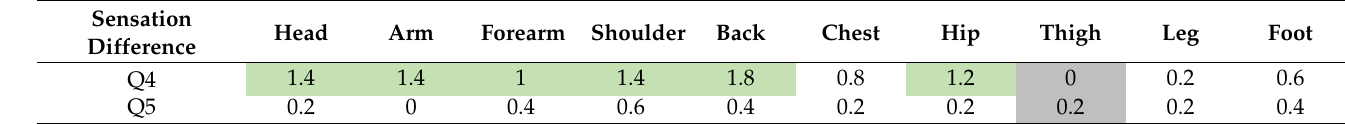
Table 9. Difference between thermal sensation level and neutral sensation level at Q4 and Q5 for the cold-sensitive group.